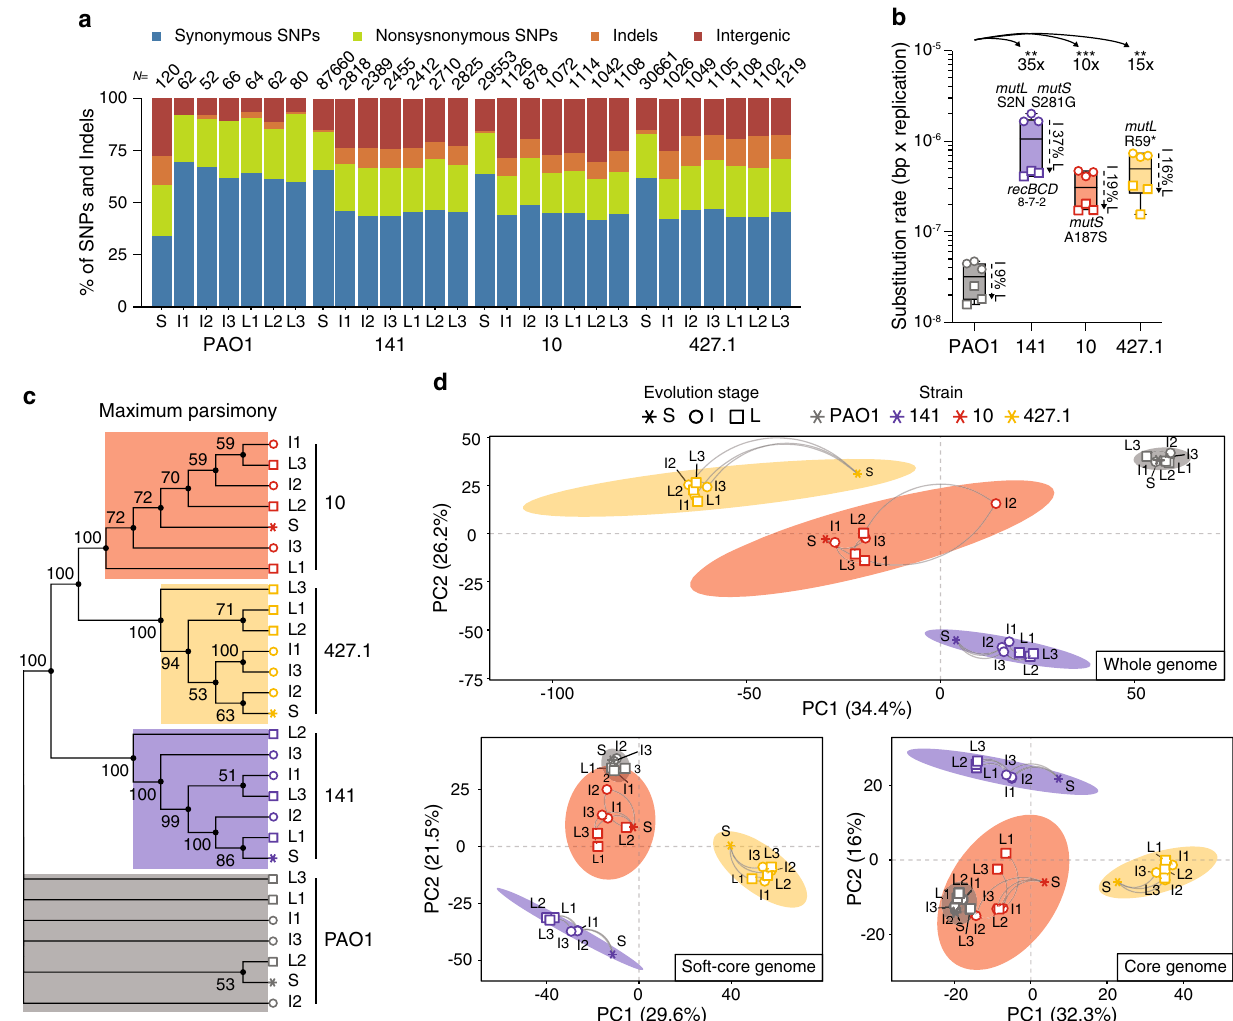
Fig. 2 Mutational pattern and transcriptional landscape of evolving Pseudomonas aeruginosa strains. a Distribution of the different types of mutations identi fi ed in the genomes of the starting (S), intermediate (I) and late (L) strains. The total number of mutations identi fi ed relative to PAO1 (S strains) or relative to each S strain (I and L strains) are shown above each column. b Substitution rate (bp per generation) for I and L evolved strains. Differences between strains were calculated on the average of the substitution rate for I and L strains. The fold-change and the signi fi cance (two-tailed Student t -test, P values: **<0.0021; ***<0.0002; n = 6 biological independent strains) relative to PAO1 are shown. The decrease in substitution rate observed in L strains is calculated as percentage relative to I strains. Data are presented as minimum, 25th percentile, median, 75th percentile, and maximum. Amino acid changes likely causing hypermutability are indicated for each strain. Numbers under the recBCD genes (141 strains) indicate the number of nonsynonymous mutations identi fi ed in each gene. c Maximum parsimony reconstruction of the sequenced strains. The tree is based on 8065 missense and nonsense SNP mutations accumulated during ALE. Branches corresponding to partitions reproduced in less than 50% of bootstrap replicates are collapsed. The percentages of replicate trees in which the associated taxa clustered together in the bootstrap test (500 replicates) are shown next to the branches. d Unsupervised principal component (PCA) analysis performed on whole, soft-core and core genome expression data for each strain. The ellipses represent the k-means clustering of the transcriptional pro fi les of the strains. Source data are provided as a Source Data fi